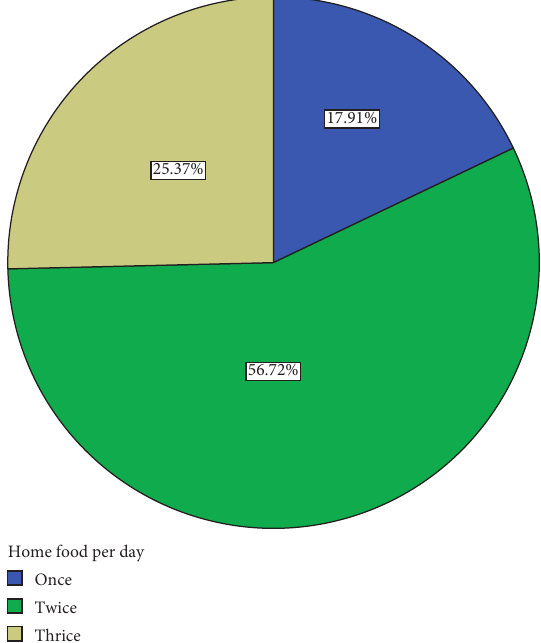
Figure 9: Distribution of number of times participants ate home- cooked food per day.